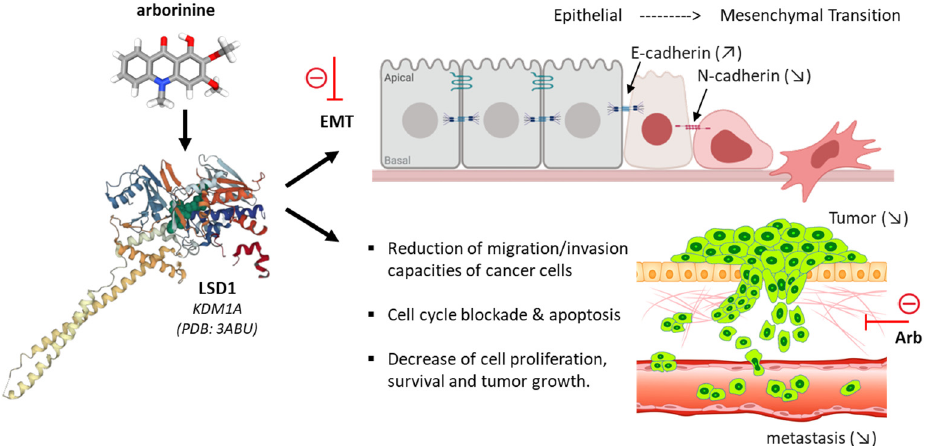
Figure 5. The structure of arborinine and its action as an inhibitor of histone lysine-specific demethylase 1 (LSD1), which is frequently overexpressed in cancer cells. Via this process, arborinine impairs the EMT dynamic (epithelial–mesenchymal transition) and reduces aggressivity of cancer cells in terms of survival, growth, dissemination and metastasis. Administered orally, arborinine can reduce tumor growth in a xenograft model of gastric cancer in mice [60].